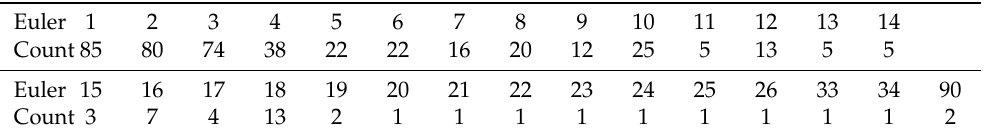
Table 15. Third decomposition type—distribution of combinatorial Euler characteristics of point complexes from border interior